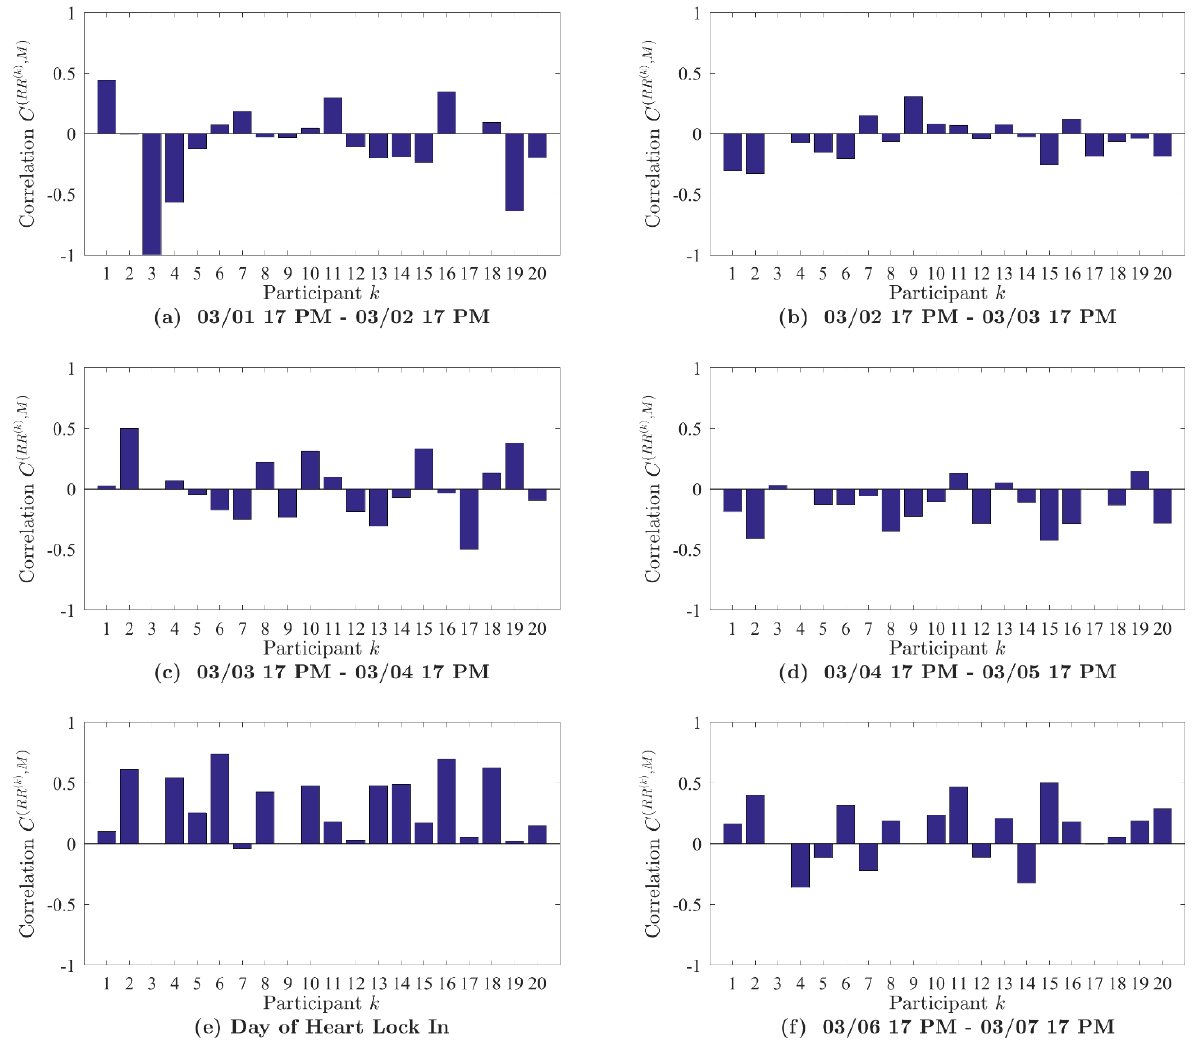
Figure A1. The results of the analysis of the LMF-HRV-synchronization for California. Each part of the figure displays participants’ LMF-HRV-synchronization for the indicated day. Plot (e) corresponds to the day of the Heart Lock-In. Note that almost all of the participants’ HRV signals shifted to being positively correlated (synchronized) with LMF, and the highest LMF-HRV-synchronization values were obtained during the day of the Heart